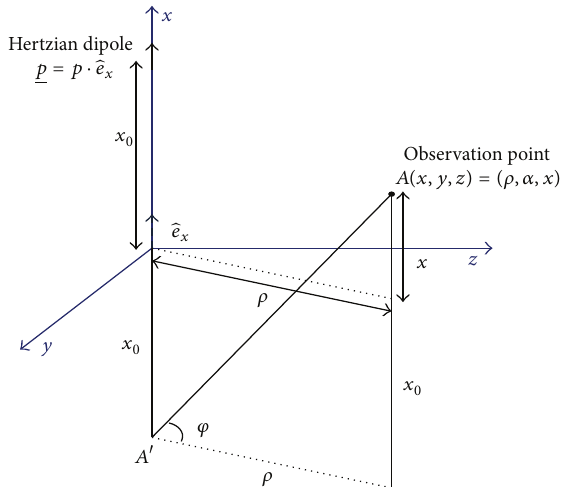
Figure 2: Geometry of the radiation problem considered in this paper, where also the image 𝐴 󸀠 of the radiating Hertzian dipole is shown. Regarding angle 𝜑 shown in this figure, cos 𝜑 is given by